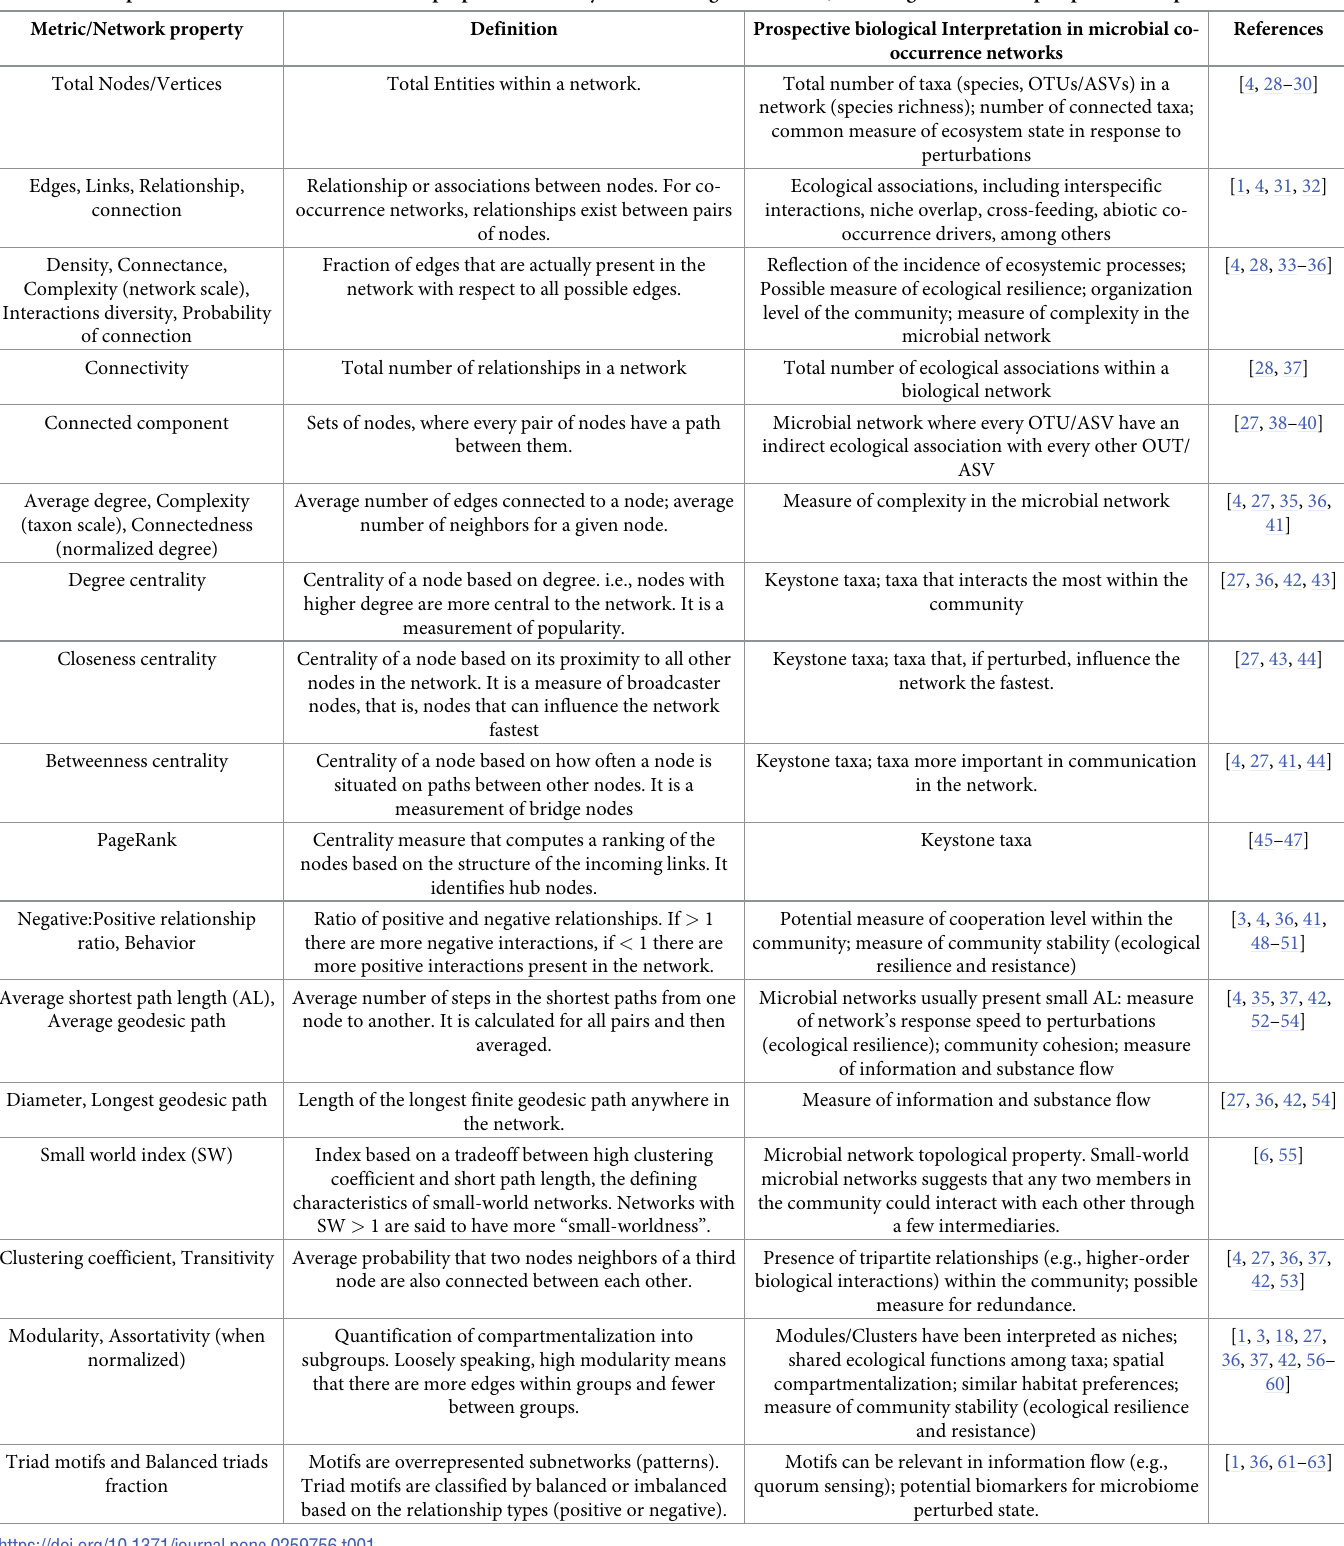
Table 1. Description of several network metrics and properties currently used in biological networks, including some of their prospective interpretations. Metric/Network